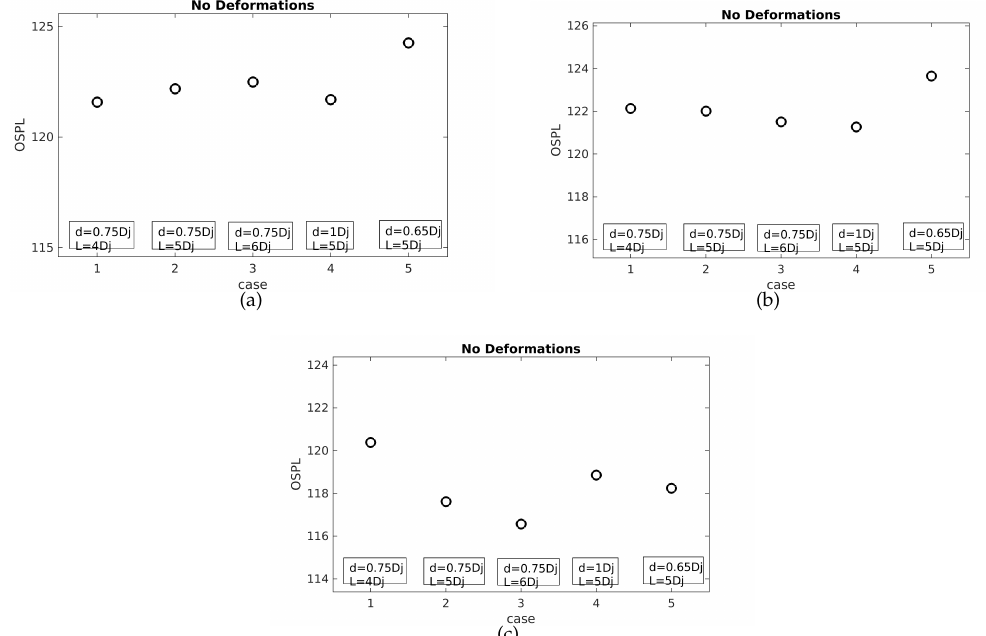
Figure 12. Level of reduction of the overall sound pressure level for all probes compared to no edge deformations: ( a ) Probe 1; ( b ) Probe 2; ( c ) Probe 3.